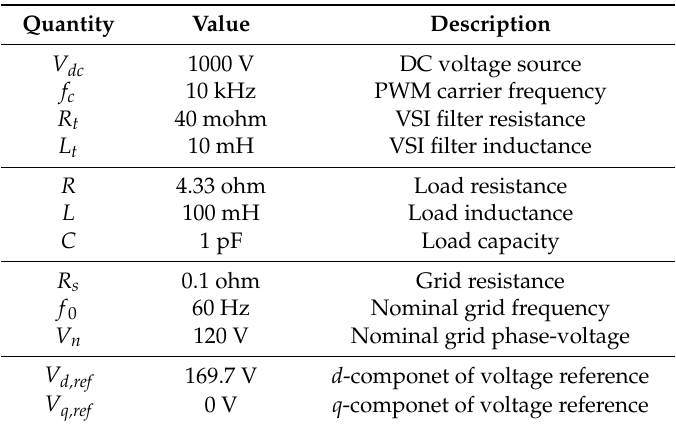
Table 1. Electrical parameters of the microgrid.